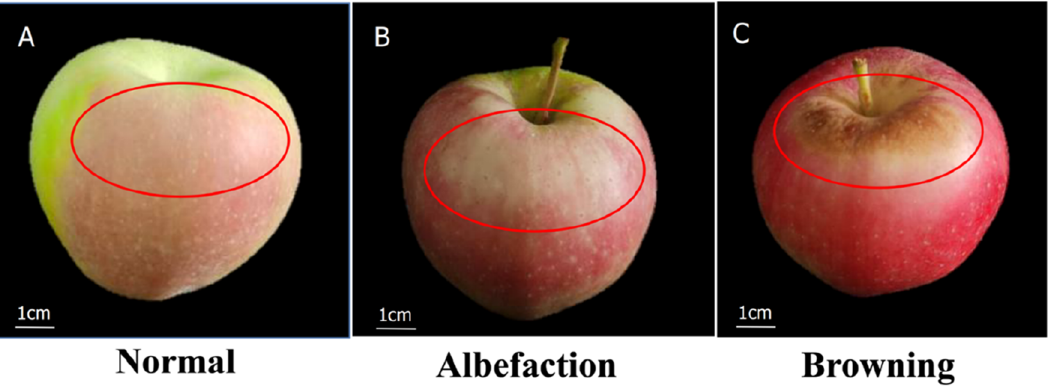
Figure 7. ‘Gala’ apples with different levels of sunburn: ( A ) no sunburn, ( B ) photooxidative sunburn, and ( C ) sunburn browning.